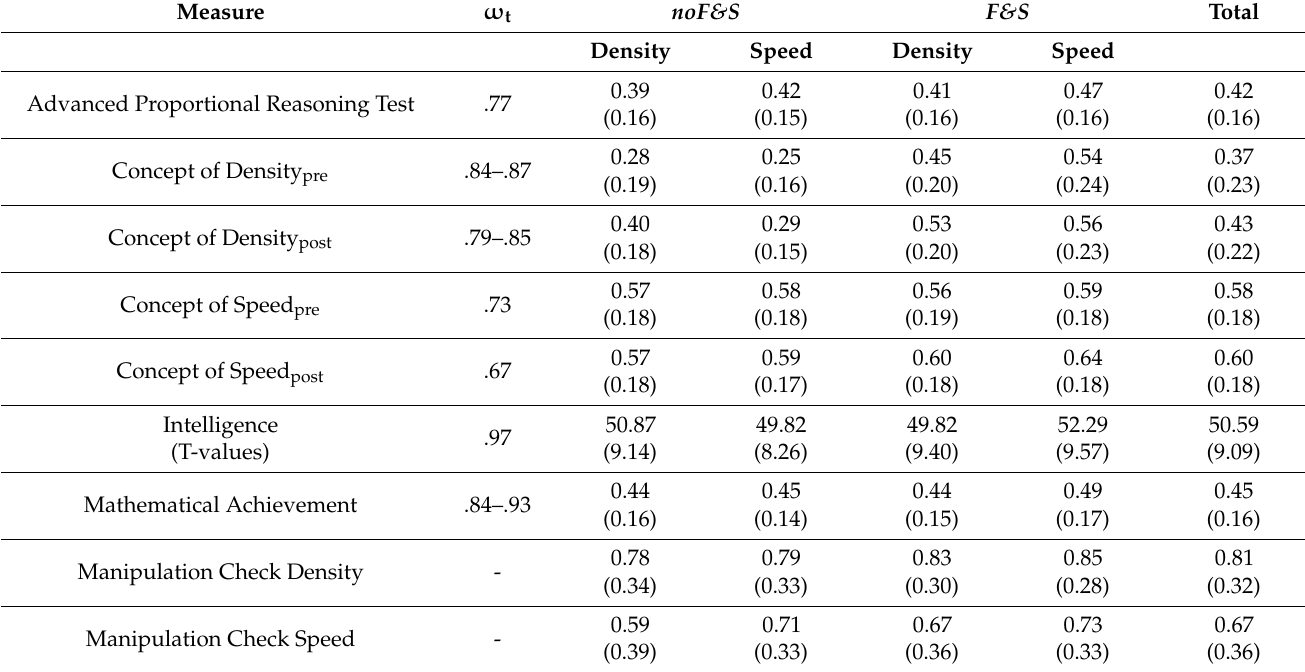
Table 3. Mean solution rates (SD) per group and for total sample in Study